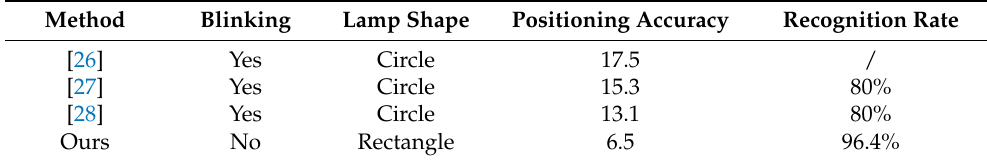
Table 3. Comparison of the method in this paper with other